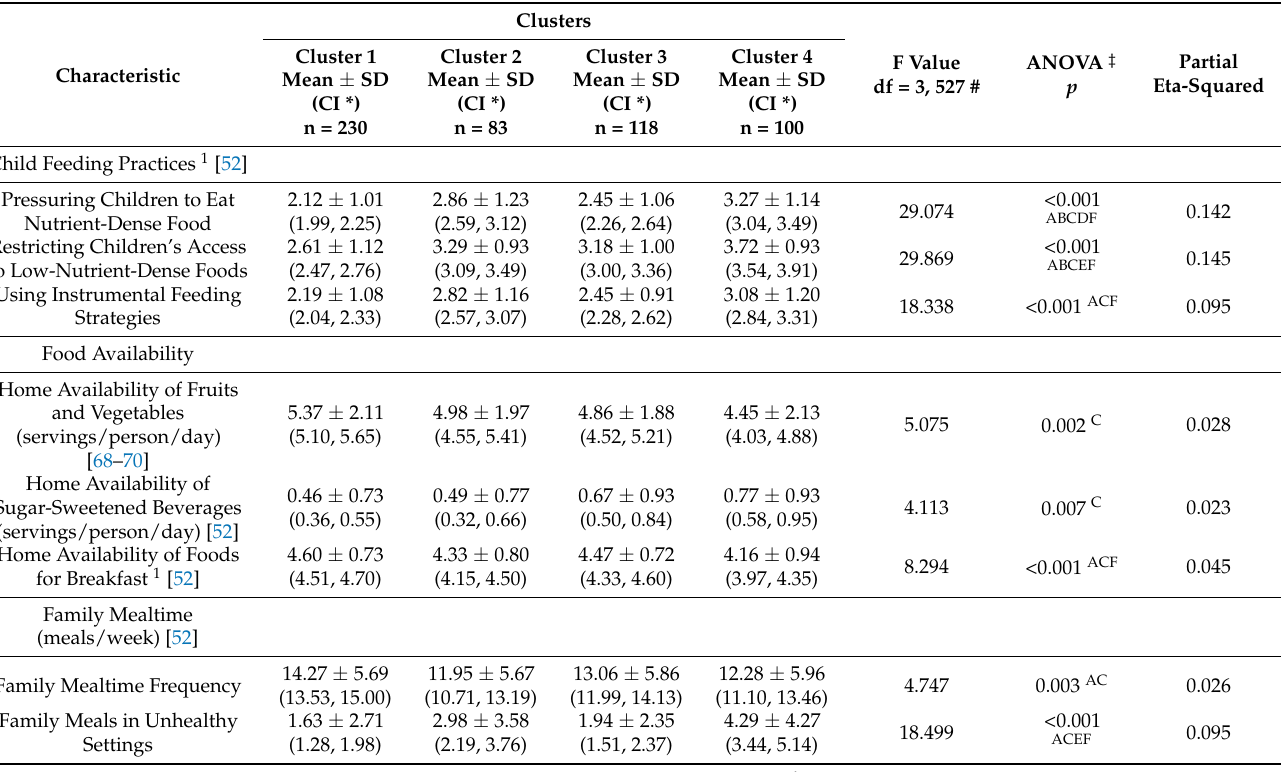
Table 4. Home Food Environment by Maternal Mental Health Status Cluster (N =